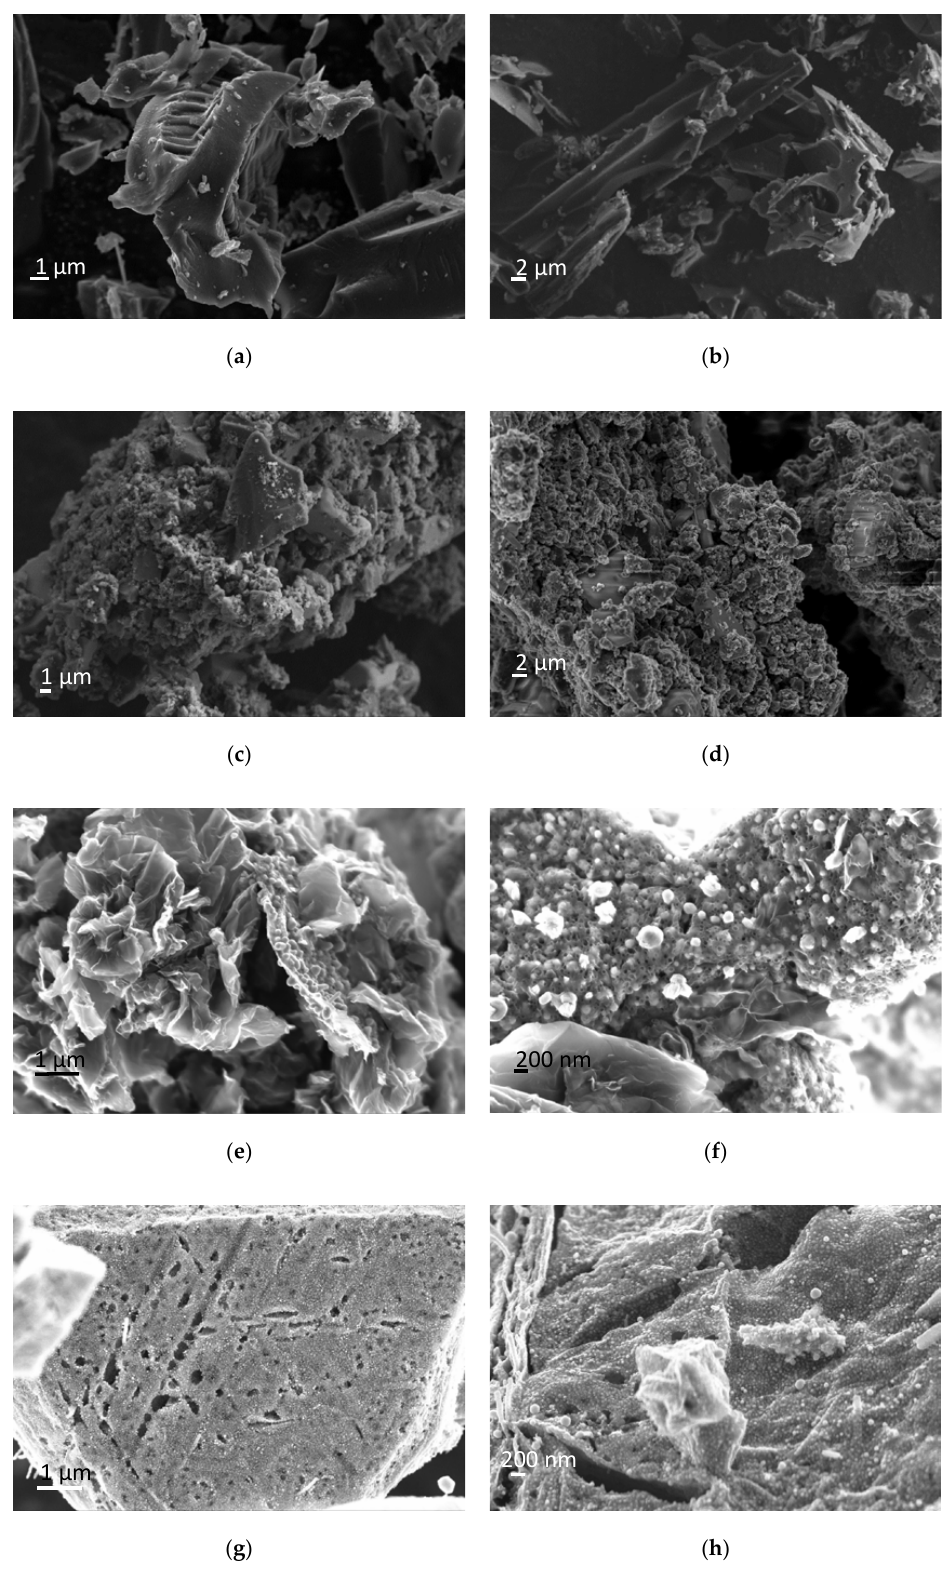
Figure 4. Representative field emission scanning electron microscopy (FESEM) images of the S ( a , b ); SCu ( c , d ); CMCuGr ( e , f ); and CMCu ( g , h )